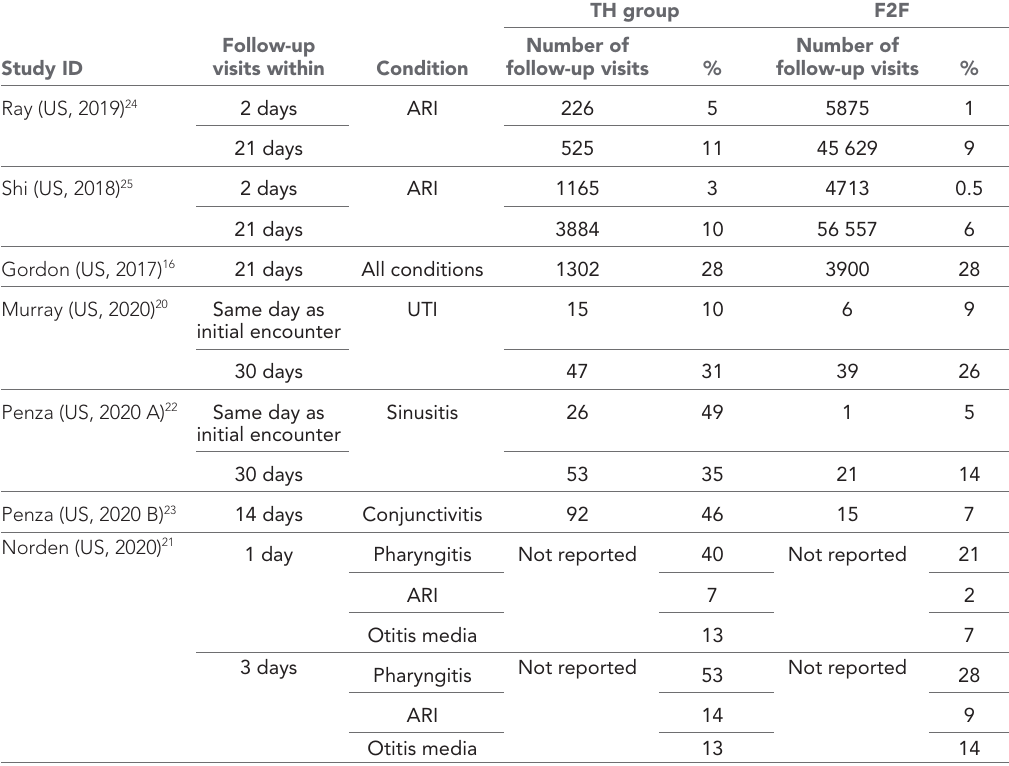
Table 3 Follow- up characteristics by initial encounter type